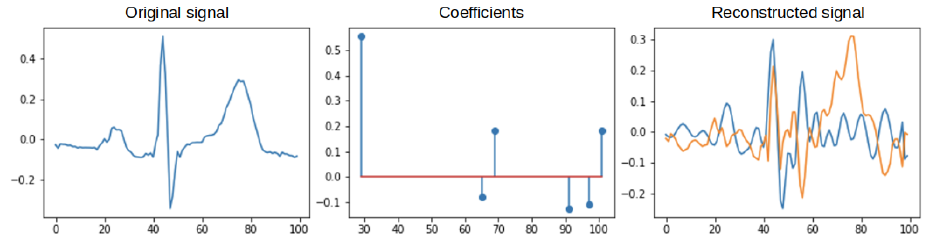
Figure 5. Example input ECG signal (original), non–zero coefficients, the signal after reconstruction.